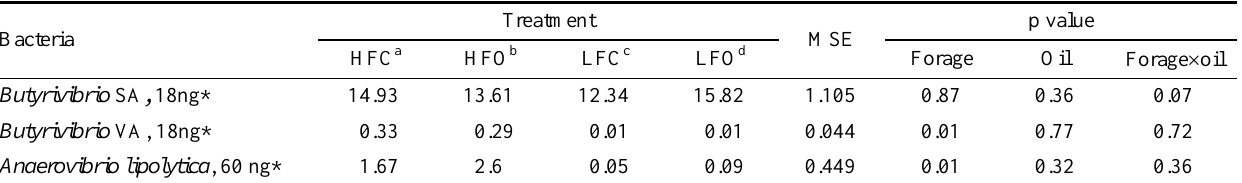
Table 4. .The effect of forage level and oil supplements on the DNA abundance (pg) of selected rumen bacteria at a given starting concentration